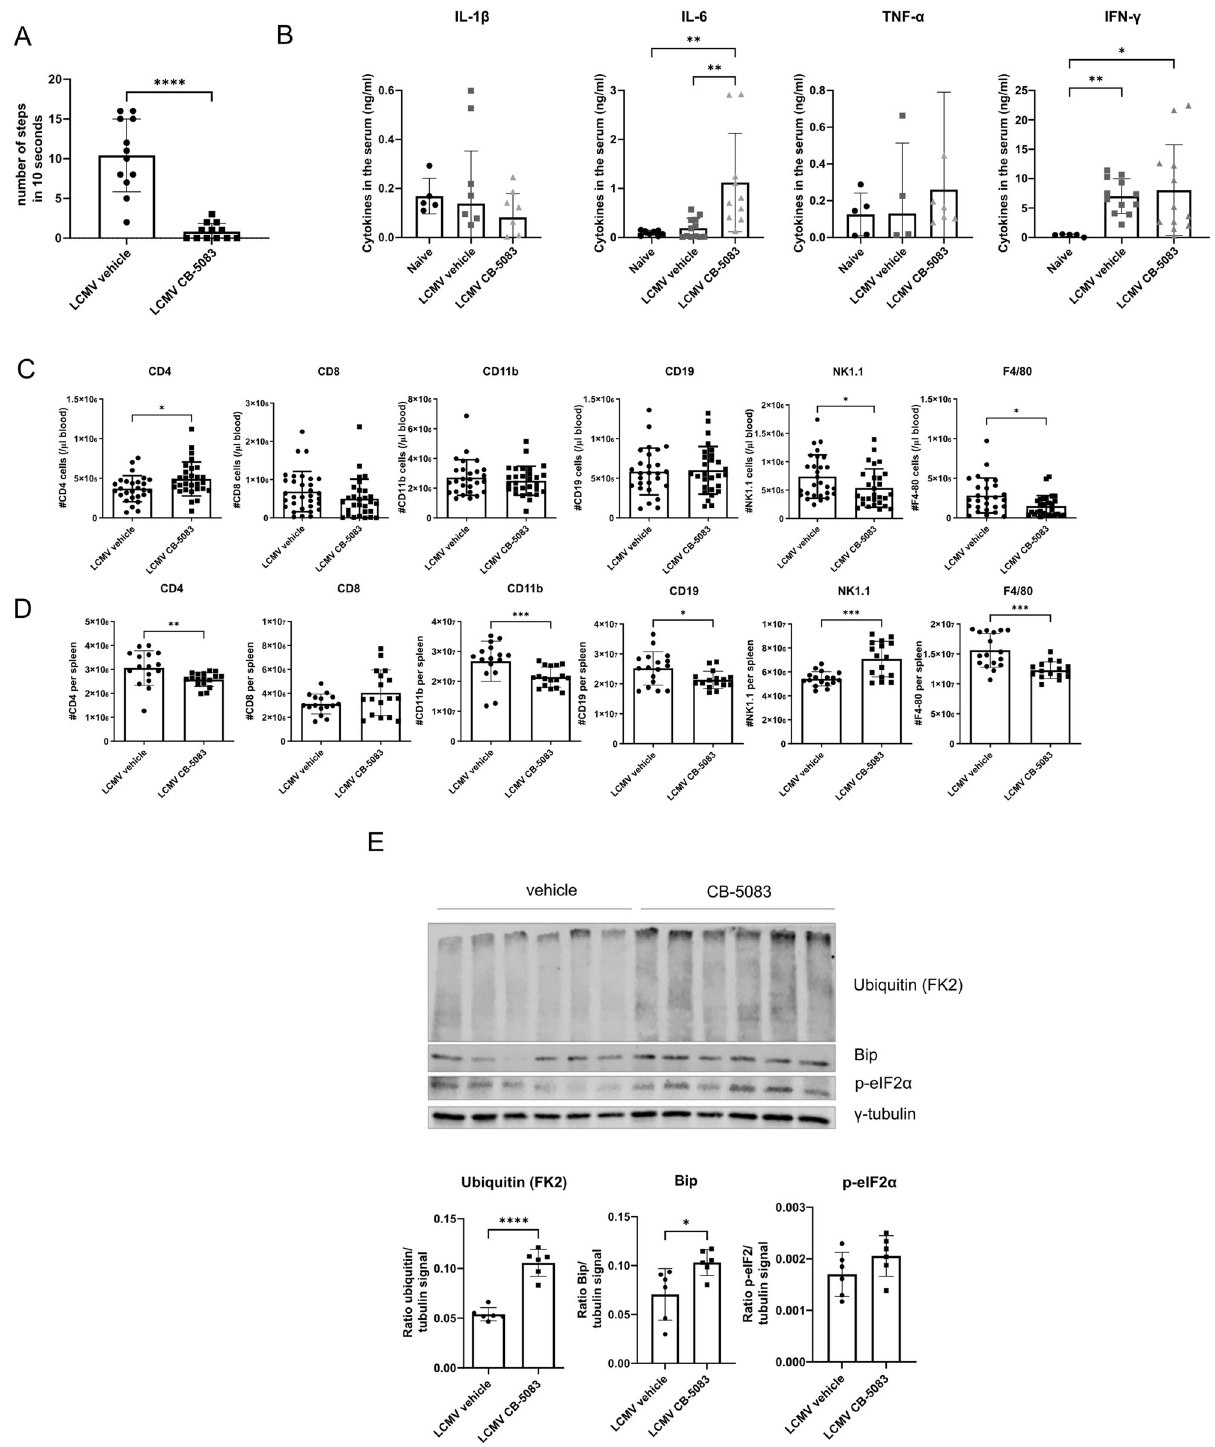
Fig. 6 CB-5083 treatment of LCMV-infected mice after the priming phase strongly impairs health status. C57BL/6 mice were infected with LCMV and treated on d6 post-infection with 50 mg/kg CB-5083 or vehicle. Mice were analyzed 6 h post-CB-5083 treatment. A The movement of the mice was tracked and the individual numbers of steps in 1 min were counted. Values represent mean ± SD. Pooled data ( n = 12) derived from two separate experiments were analyzed by unpaired t test. B IL-1 β , IL-6, TNF- α , and IFN- γ concentrations were determined in the serum ( n = 5 – 12). Values represent mean ± SD. For each analysis, a Kruskal – Wallis test followed by a Dunn ’ s test was performed. C , D The blood ( C ) ( n = 27 – 32) and spleen ( D ) ( n = 16-17) were collected and stained for CD4, CD8, CD11b, CD19, F4/80 and NK1.1 and analyzed by fl ow cytometry. The data was pooled from three different experiments and analyzed by unpaired t test. Values represent mean ± SD. E Splenocytes were lysed and analyzed via immunoblot for poly-ubiquitin accumulation, BiP, and p-eIF2 α . On the γ -axis, the mean signal normalized to γ - tubulin ± SD from mice ( n = 6) derived from two independent experiments analyzed by an unpaired t test is shown. All values represent mean ± SD. * p < 0.05, ** p < 0.01, *** p < 0.001, and **** p < 0.0001.